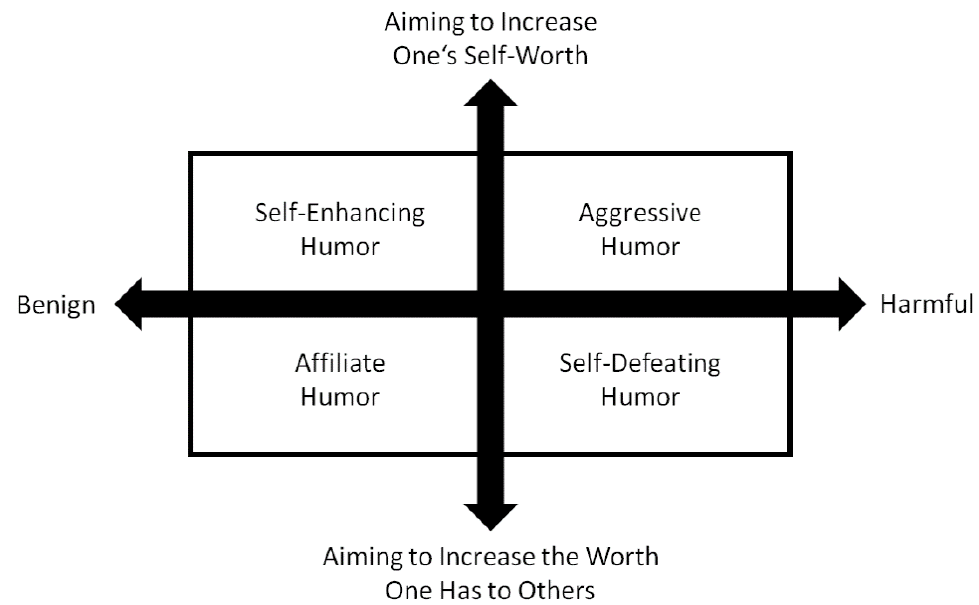
Figure 1. Model of the four humor styles and the intersection of the two dimensions benign vs. harmful and aiming to increase the self-worth vs. aiming to increase the worth one has to others .